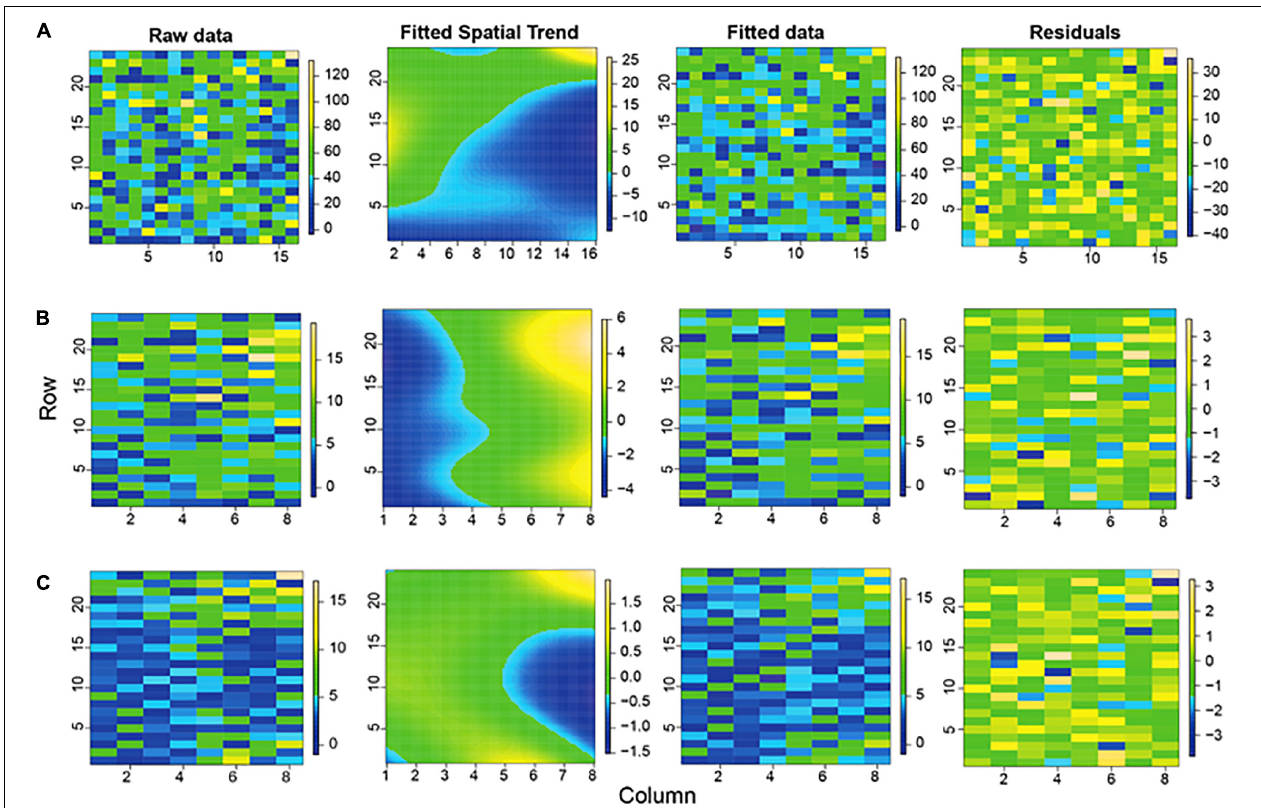
FIGURE 1 | Graphical representations of the raw data, fitted spatial trend, fitted data, and residuals for the biomass trait (total fresh weight, TFW) of the wet season under rainfed (WS-RF) (A) , under moderate water stress in dry season (DS-MWS) (B) , and severe water stress in dry season (DS-SWS) (C)